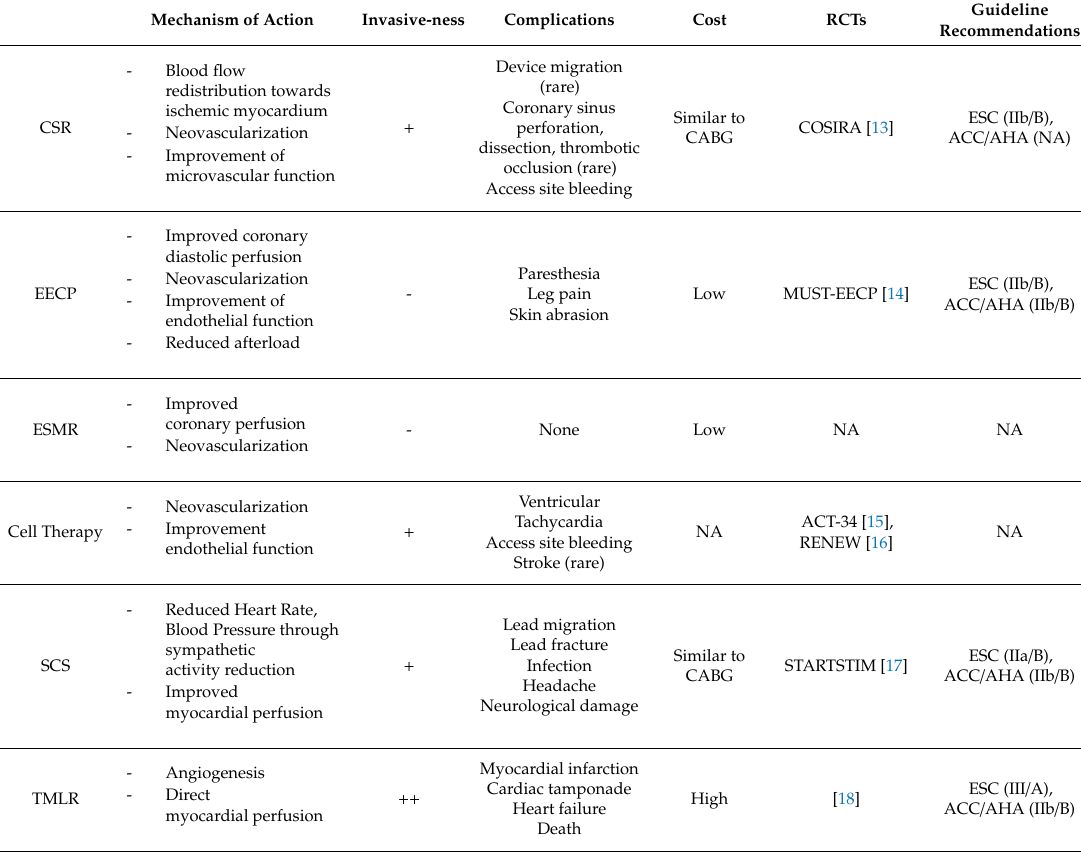
Table 1. Main characteristics of novel techniques in Refractory